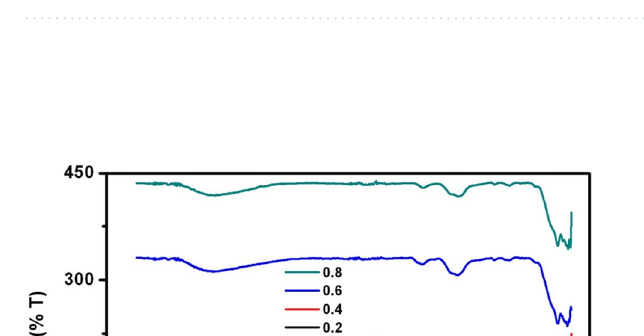
Figure 5. TEM photos of SLFO nanoparticles.